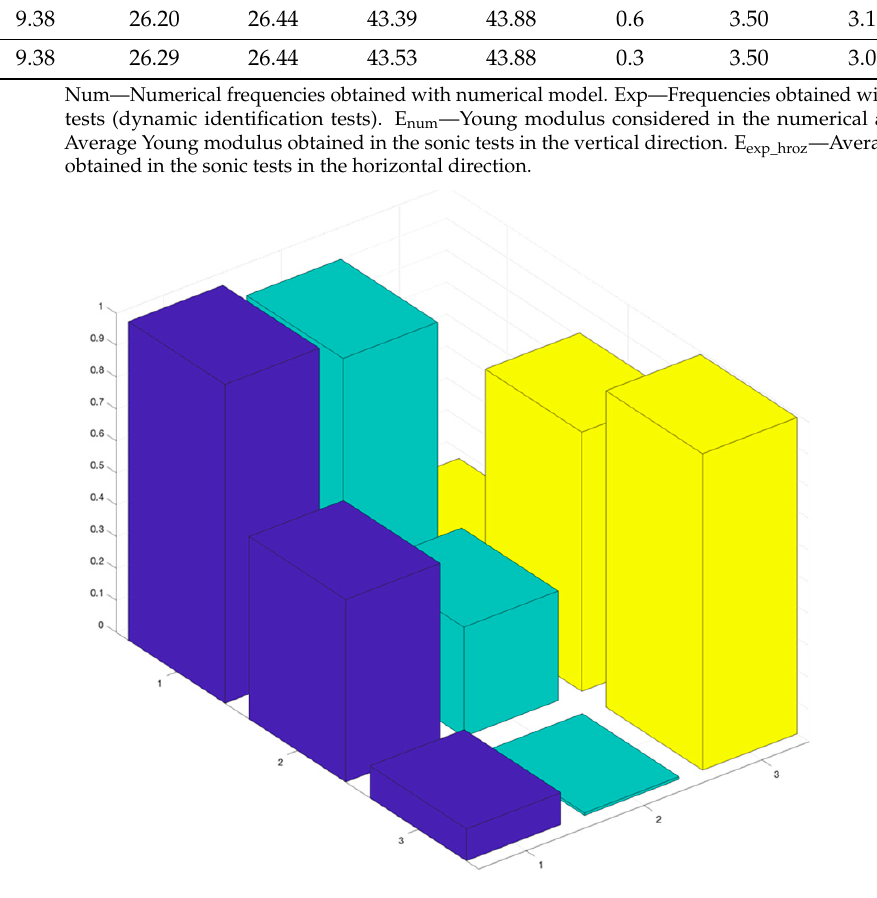
Figure 11. MAC correlation